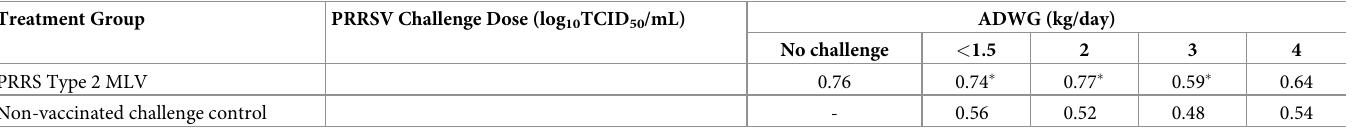
ADWG was greater for vaccinated, challenged pigs compared with non-vaccinated, challenged pigs in all challenge dose groups. ADWG was significantly greater in groups challenged with < 1.5, 2 and 3 log PRRSV (Groups 1, 2 and 3, respectively [P < .05]). ADWG for vaccinated pigs challenged with < 1.5 and 2 log PRRSV (Groups 1 and 2, respectively) had an ADWG of 0.74 and 0.77 kg/day respectively, which is numerically similar to that of vaccinated, non-chal- lenged pigs (0.76 kg/day [Table 3]). Table 3. ADWG by treatment group and challenge dose. Treatment